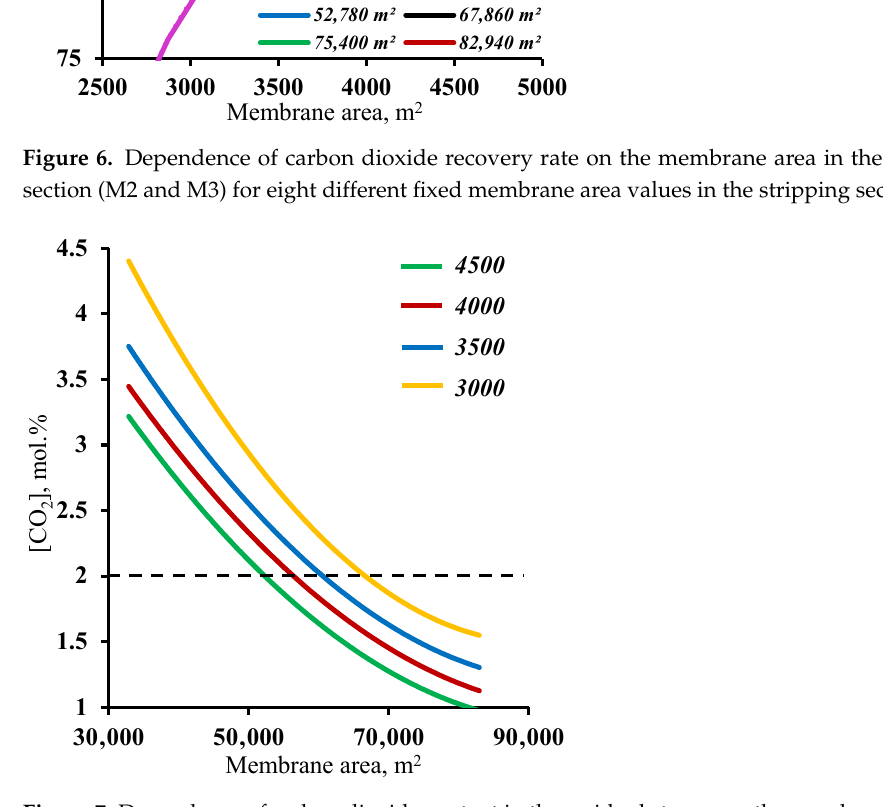
Figure 7. Dependence of carbon dioxide content in the residual stream on the membrane area in the stripping section (M1) for four different fixed values of the membrane area in the enrichment section (M2 and M3).